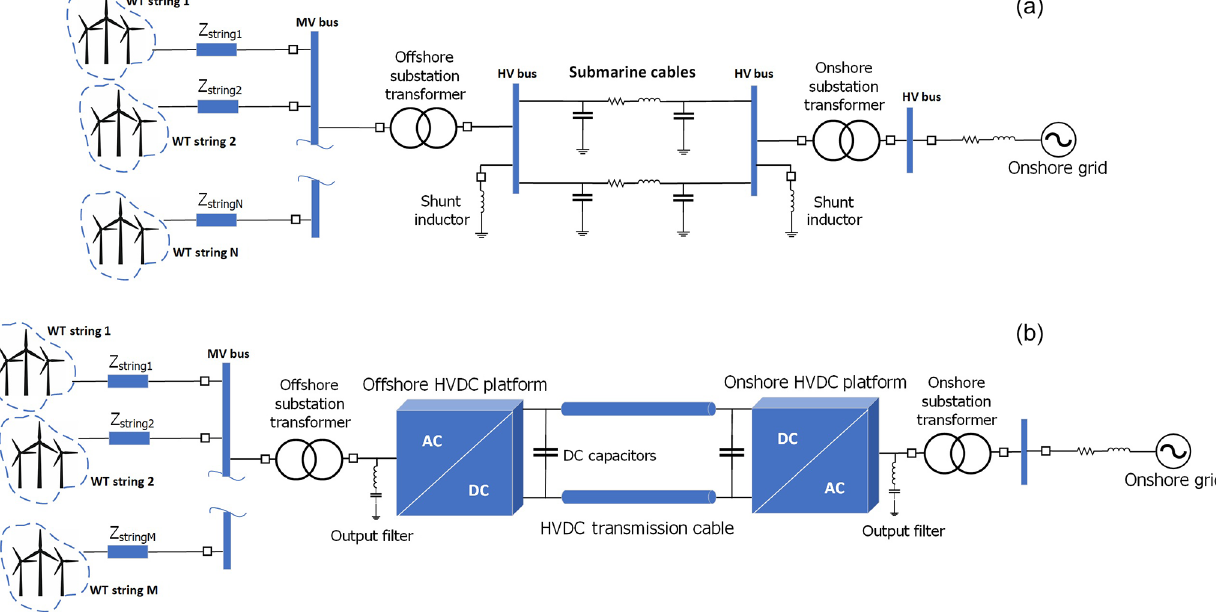
Figure 2. Typical structure of AC-connected (a) and HVDC-connected (b) offshore WPPs (Cutululis, 2018; Kalair at al.,